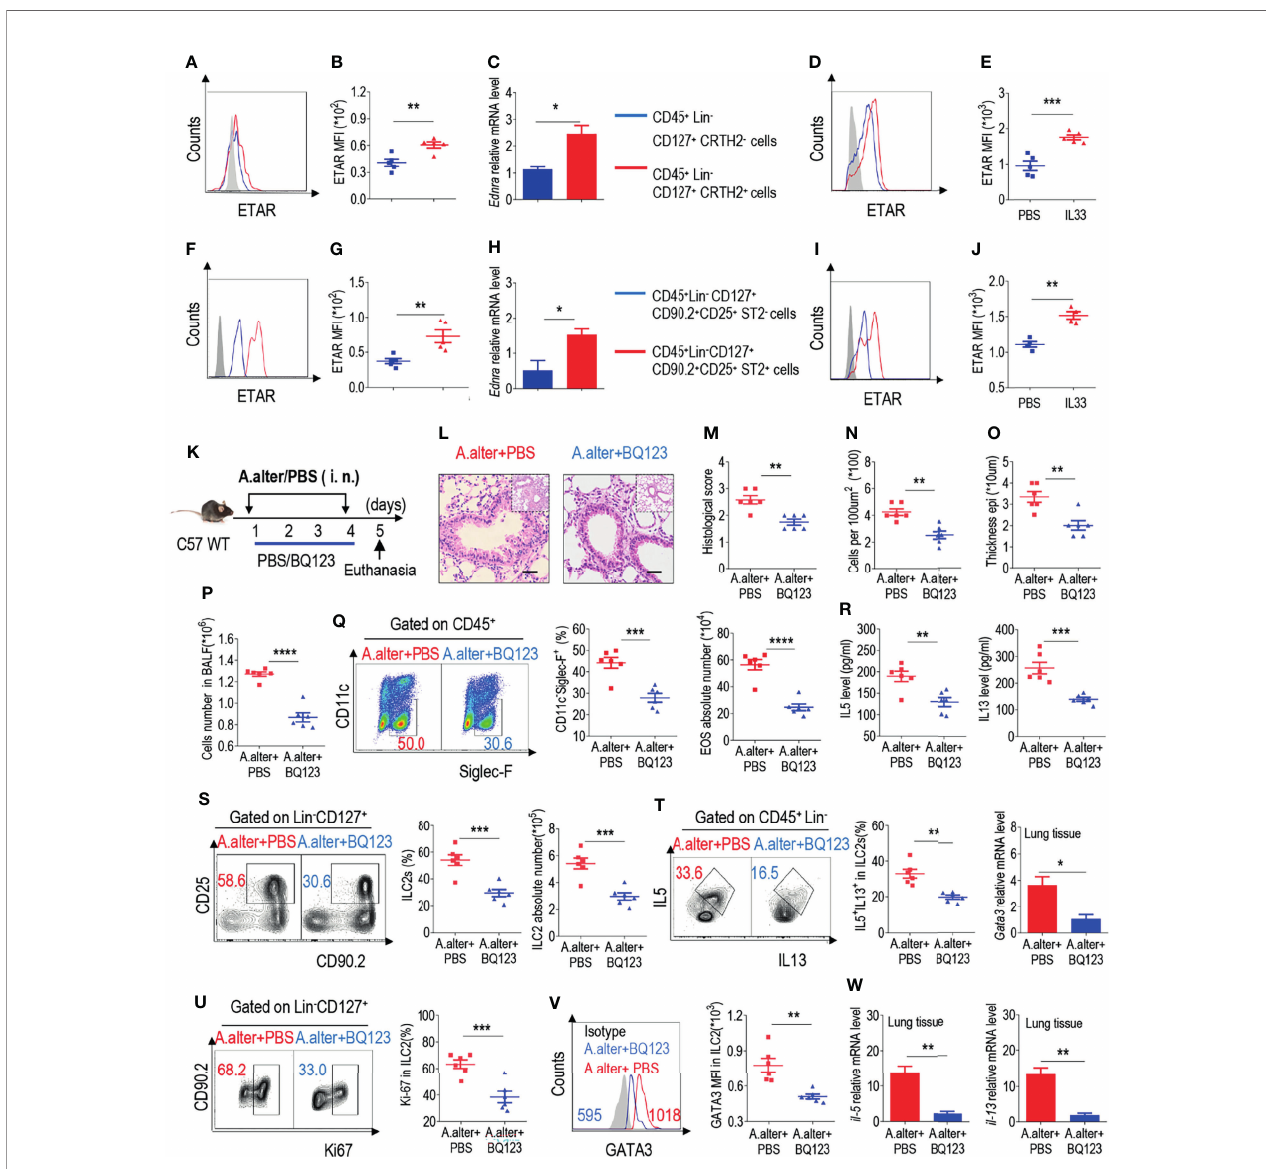
FIGURE 1 | BQ13 exhibited protective effects against Alternaria alternata-induced airway in fl ammation. (A) Representative the mean fl uorescence intensity (MFI) from human ILC2s of ETAR-expressing CD45 + Lin - CD127 + CRTH2 - and CD45 + Lin - CD127 + CRTH2 + cells (n = 5). (B) Statistical analysis of ETAR expression. (C) mRNA expression levels of human endothelin receptor A ( Ednra ) were evaluated; b -actin level was used for normalization, and the lowest expression level in Ednra -negative cells was arti fi cially set to 1 (n = 3). Puri fi ed ILC2s from mouse lung and human PBMCs were cultured with rm/rh-IL-2, rm/rh-IL-7 and with or without rm/rh-IL-33 for 72 h. Then ETAR expression levels were analyzed by fl ow cytometry. Representative MFI (D, I) and statistical analysis (E, J) of ETAR expression were shown. (F) Representative results of fl ow cytometry MFI from mouse lung ILC2s of ETAR-expressing CD45 + CD4 - Lin - CD127 + CD90.2 + CD25 + ST2 - and CD45 + CD4 - Lin - CD127 + CD90.2 + CD25 + ST2 + cells (n = 5). (G) Representative statistical analysis of ETAR expression. (H) mRNA expression levels of mouse Ednra were evaluated; b -actin level was used for normalization, and the lowest expression level in Ednra -negative cells was arti fi cially set to 1 (n = 3). (K) Experimental scheme. Female C57BL/6J mice were intranasally challenged with A. alternata on days 1 – 4 and were sacri fi ced 24 h after the last challenge on day 5. (L – O) Representative hematoxylin and eosin (H&E) staining of lung sections (L) and in fl ammation scores (M) , as well as the in fi ltrating cells (N) and airway epithelium thickness (O) were shown. Absolute number of BALF (P) , typical example of fl ow cytometry (left) and statistical results (right) both population and the absolute numbers of EOS in the bronchoalveolar lavage fl uid (BALF) (Q) were indicated. (R) IL-5 and IL-13 levels in BALF were determined. (S – V) Representative results of fl ow cytometry, statistical analysis of the frequencies of ILC2s and absolute counts (S) , IL-5 + IL-13 + ILC2s (T) , Ki67 + ILC2s (U) , and levels of GATA3 (V) in the lungs were shown. (W) The mRNA expression levels of ILC2-related target genes in lung tissues, including Il5, Il13 , and Gata3 , were evaluated; b -actin level was used for normalization, and the lowest expression level in the A. alternata + BQ123 group was arti fi cially set to 1 (n = 3). Data are representative of two or three independent experiments (n = 6 for the A. alternata + PBS group; n = 6 for the A. alternata + BQ123 group). *P < 0.05; **P < 0.01; ***P < 0.001; ****P < 0.0001. In all panels, individual results and mean ± standard error of the mean (SEM) are shown; statistical signi fi cance was determined using a two-tailed unpaired Student ’ s t-test (B, C, E, G, H, J, M – U, W) or Mann-Whitney test (V)